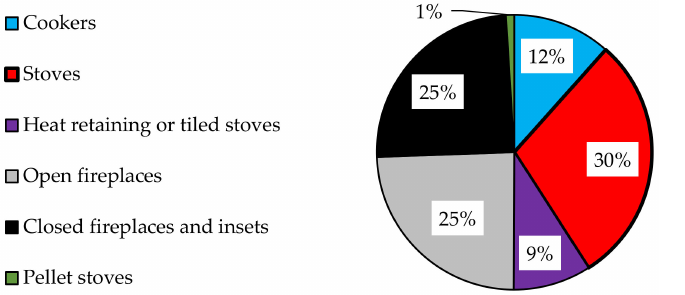
Figure 1. Share of technologies in about 65 million room-heating appliances in Europe. Own figure, based on data of